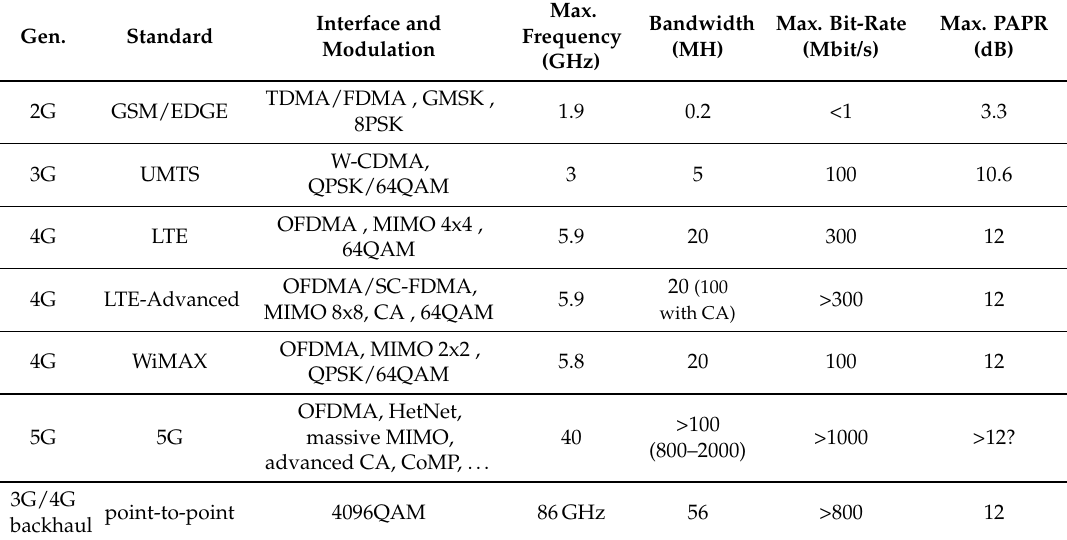
Table 1. Features of digital mobile communication standards and of microwave backhaul connections.